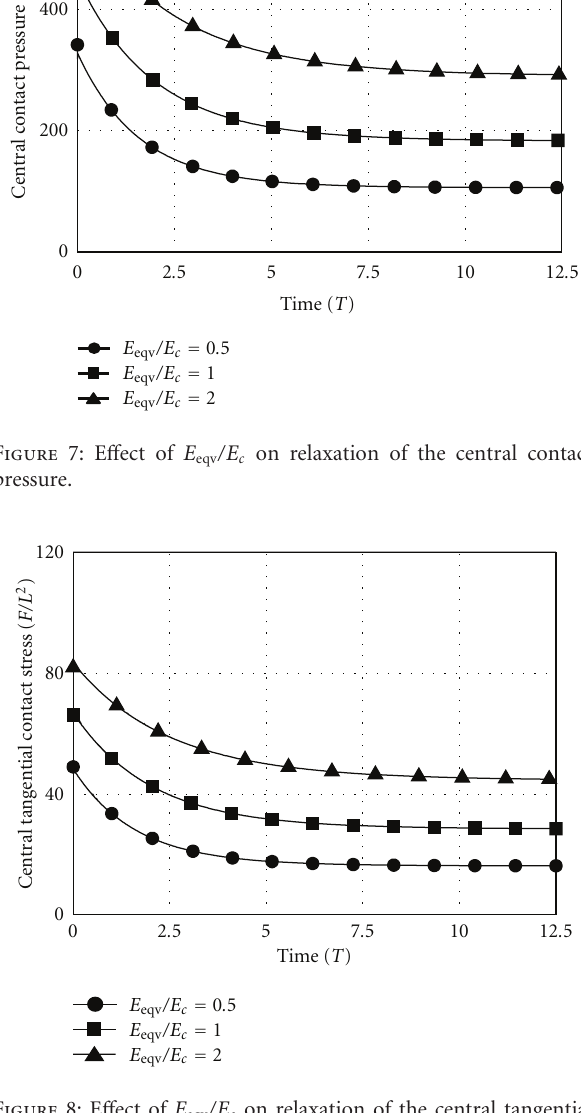
Figure 8: E ff ect of E eqv /E c on relaxation of the central tangential contact